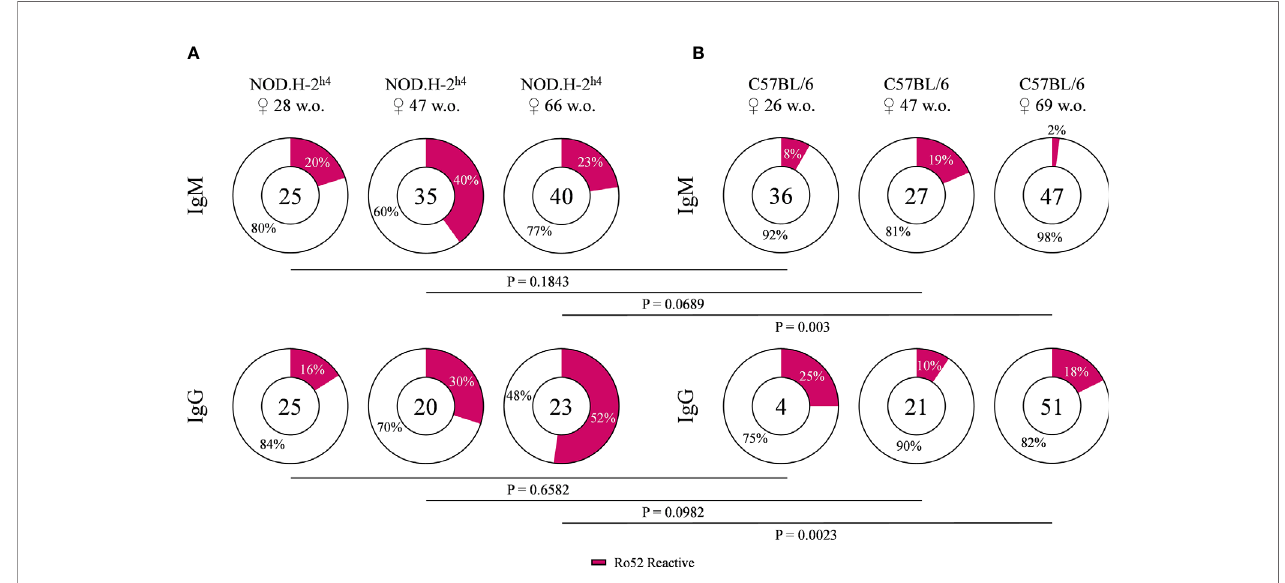
FIGURE 2 | Frequency of Ro52 speci fi c antibodies. Pie charts showing the proportion of Ro52 reactive (magenta) and non-reactive (white) antibodies, from NOD.H- 2 h4 (A) and C57BL/6J (B) , determined by ELISA. Data for each age NOD.H-2 h4 : 28, 47 and 66 w.o., C57BL/6J: 26, 47 and 69 w.o.; and both IgM and IgG isotypes are shown. The number of tested antibodies is indicated in the pie chart center. Data are pooled from independent experiments for each mouse age. P-values were calculated by c 2